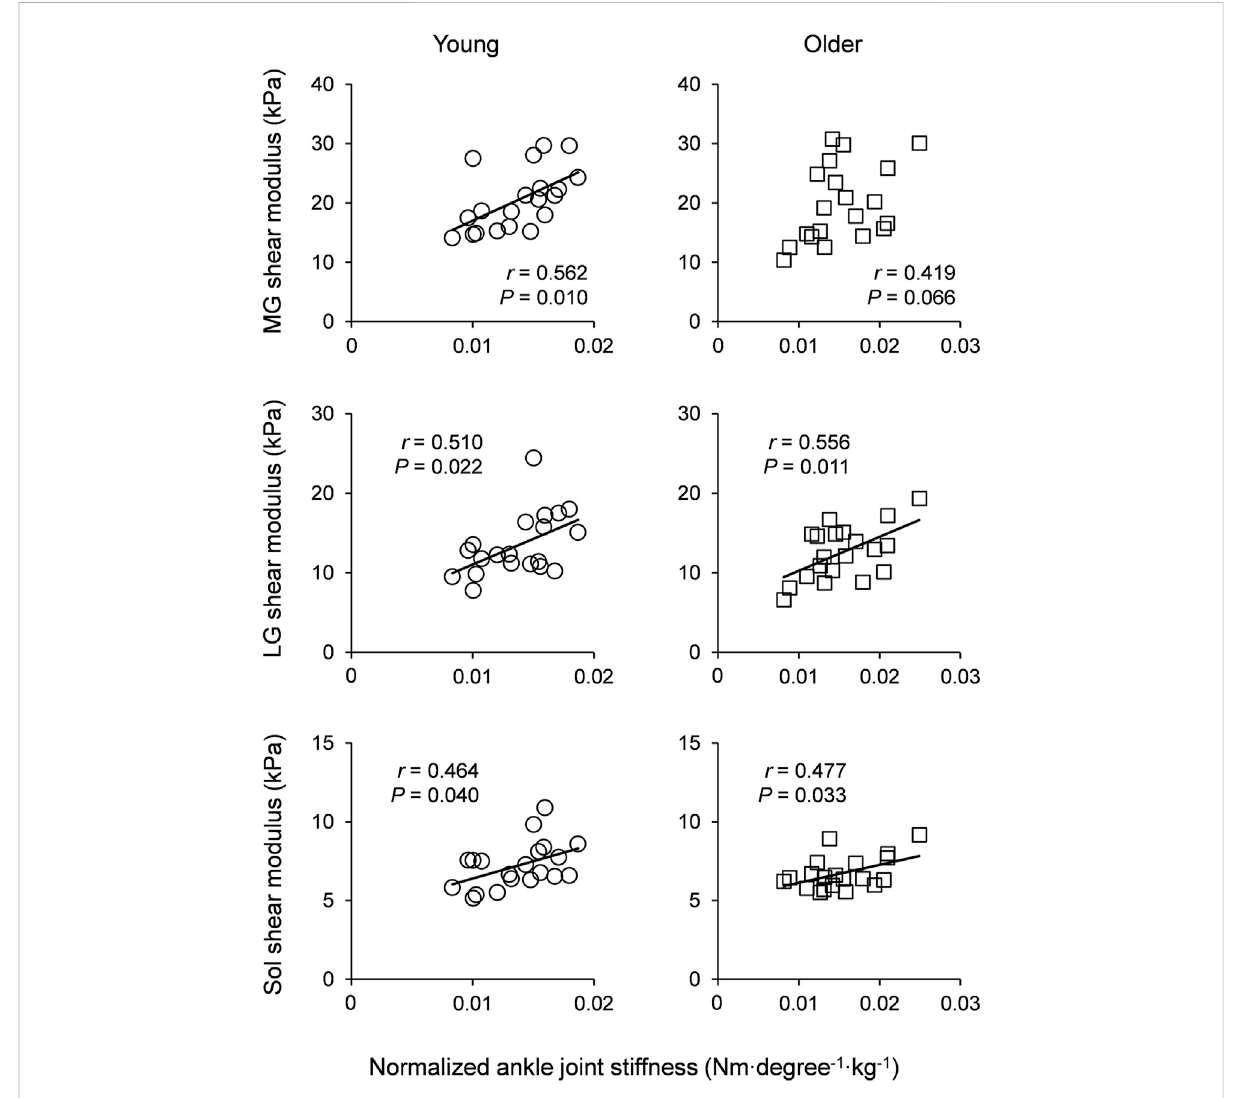
FIGURE 2 Scatter plots of normalized ankle joint stiffness with muscle shear modulus of the triceps surae for young participants (left column) and older participants (right column). Linear regression lines were drawn for signi fi cant correlations as solid lines. MG: medial gastrocnemius, LG: lateral gastrocnemius, and Sol: